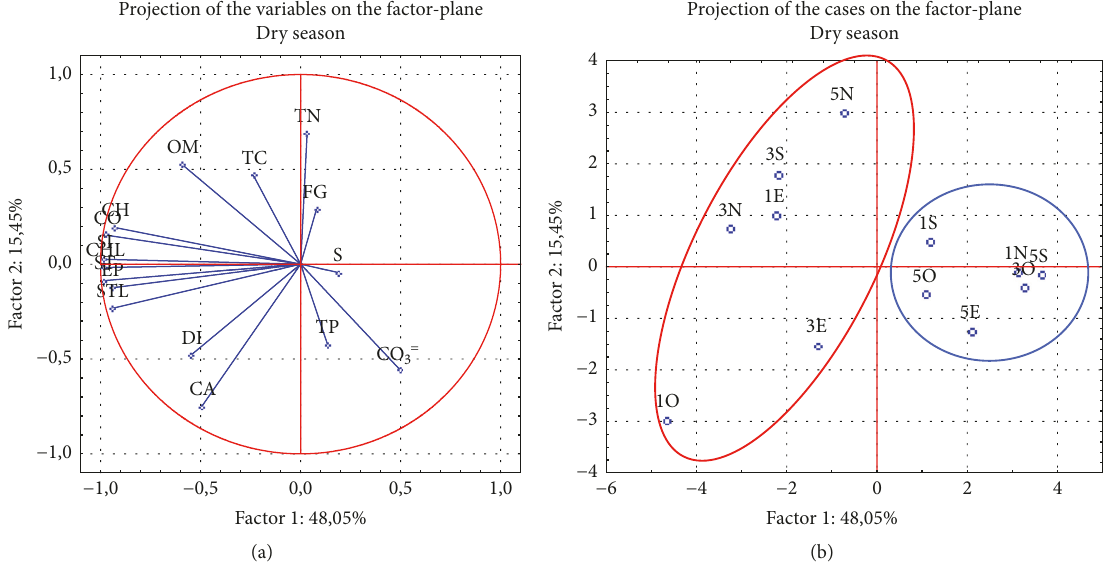
Figure 7: Principal Component Analysis (PCA) by variable (a) and site (b) based on presence and concentration of sterols at each sampling station in dry season. The red circle identifies the stations with coprostanol and epicoprostanol presence and blue circle includes those stations with little or no influence from the X’Buya-Ha